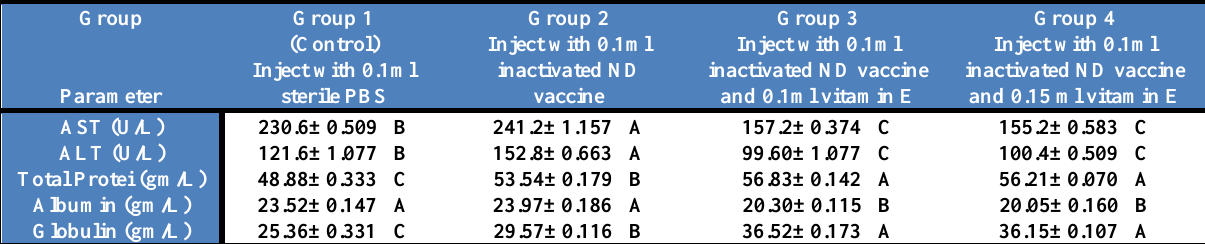
Table, 3: Effect of vitamin E in biochemical parameters for different groups at 35 days old. (Mean ± Standard